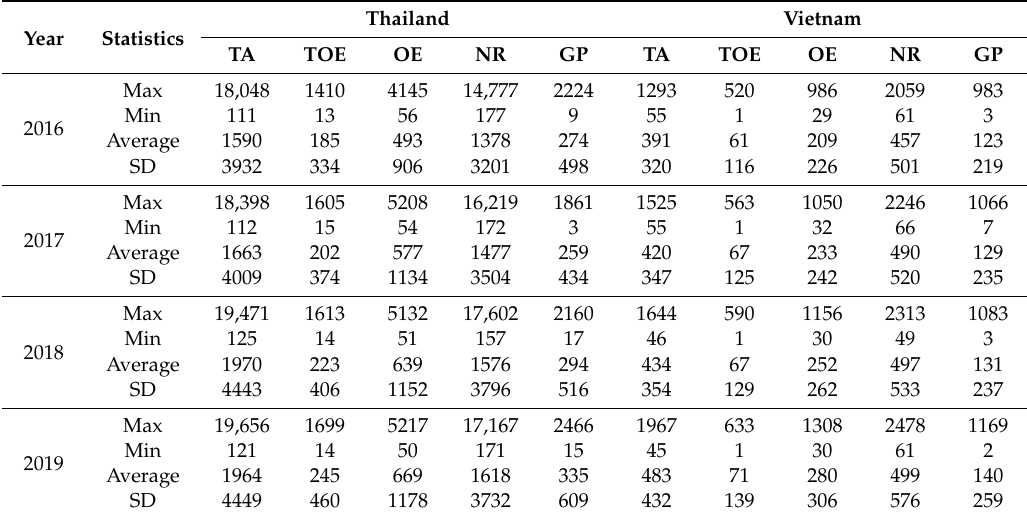
Figure 2. Operational process of F&B companies. Table 3. Main statistics of inputs/outputs for Vietnam and Thailand (2016 – 2019).